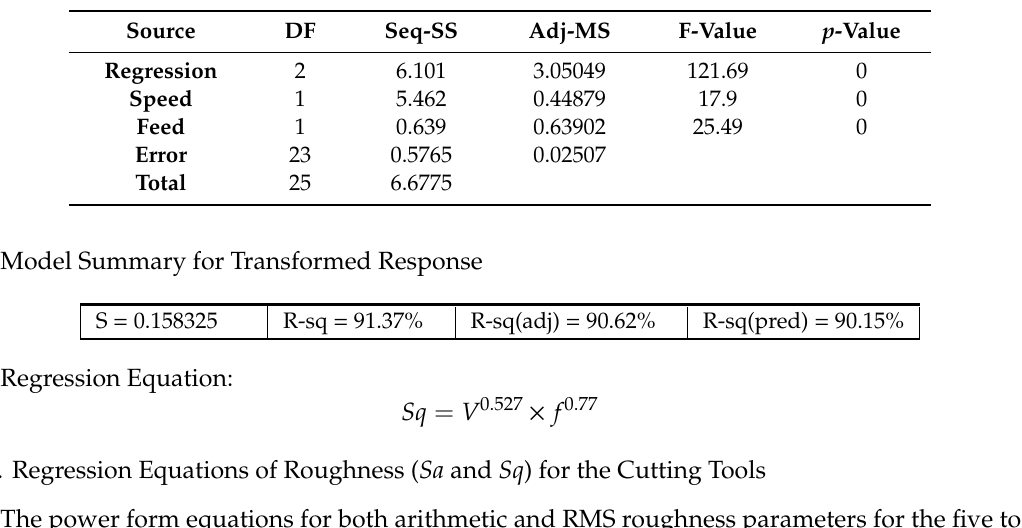
Table 6. Analysis of variance for transformed response for Sq (Tool 3).